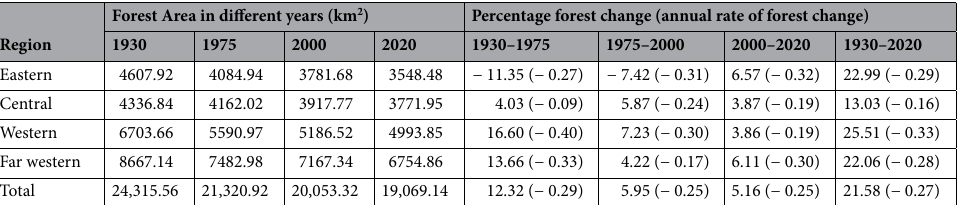
Table 1. Status of forest cover by area in 1930, 1975, 2000 and 2020 in Chure Terai Madhesh Landscape (CTML), Nepal. The total forest change percentage and annual rate of forest change (in parenthesis) is presented for four different time